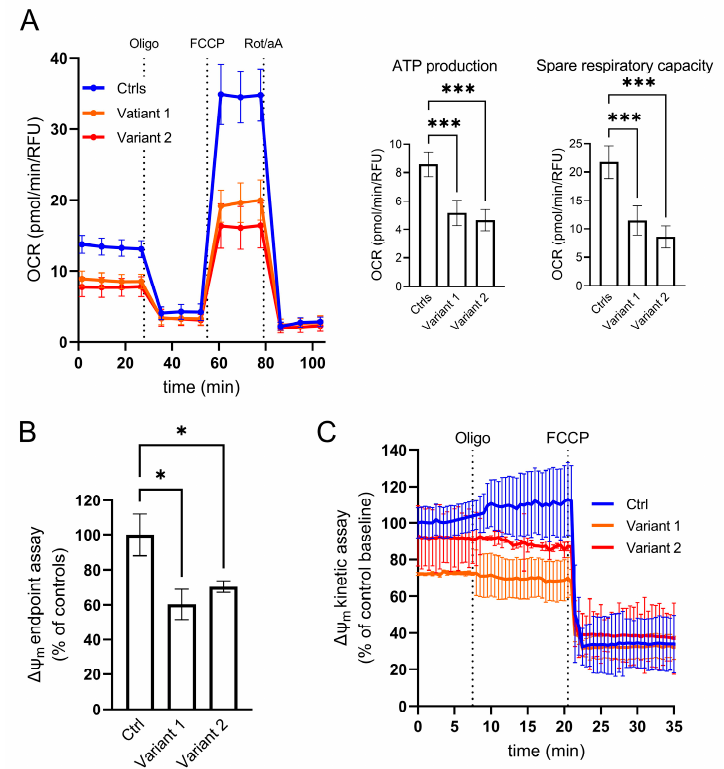
Figure 2. Cellular analysis of mitochondrial function. ( A ) Micro-oxygraphy track showing a reduced OCR in mutated cell lines, which is clearly evident after FCCP injection, reflecting a deficient